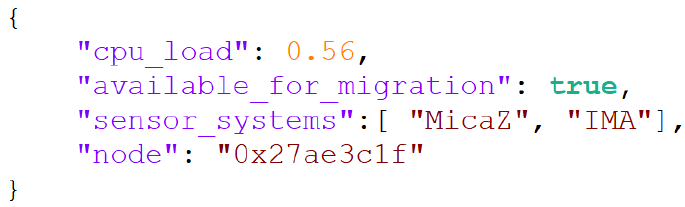
Figure 4. Example of message produced from Policy in Figure